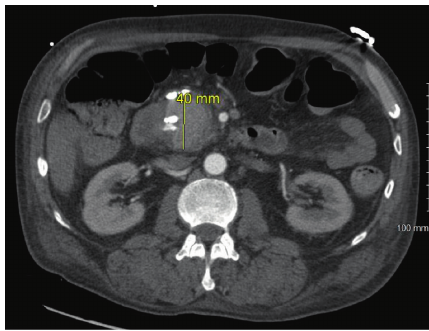
Figure 1: Computed tomography with angiography with mea- surement of pseudoaneurysm.